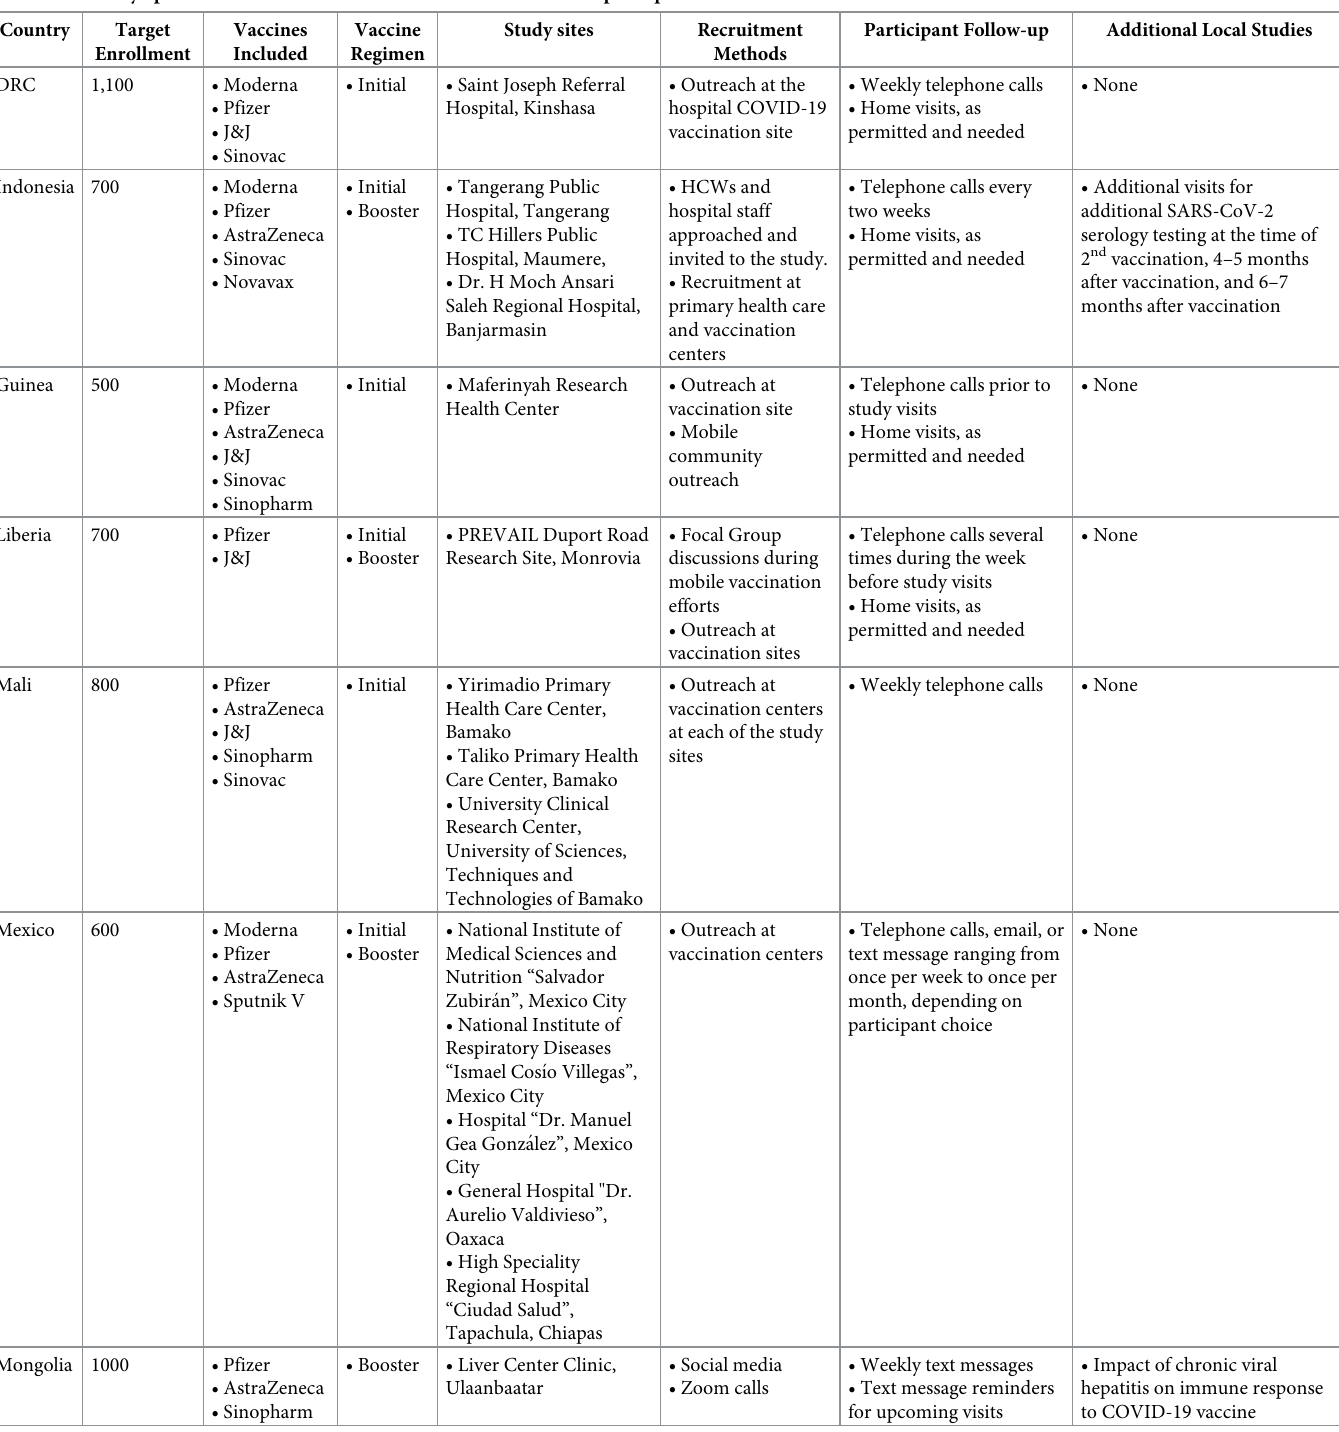
Table 2. Country-specific information related to enrollment and follow-up and planned local studies.